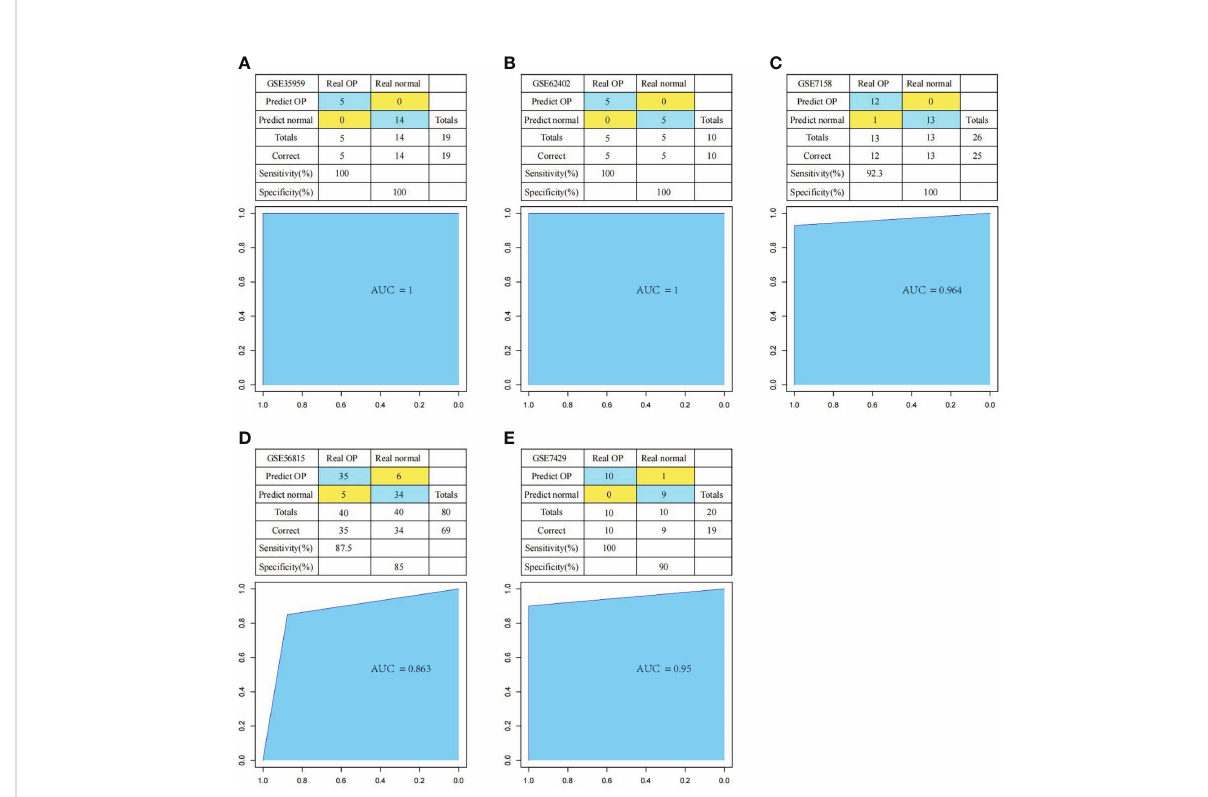
FIGURE 11 Performance of the diagnostic model in distinguishing normal samples and OP samples. The classi fi cation results and the ROC curves of the diagnostic model for set GSE35959 (A) , GSE62402 (B) , GSE7158 (C) , GSE56815 (D) and GSE7429 (E)